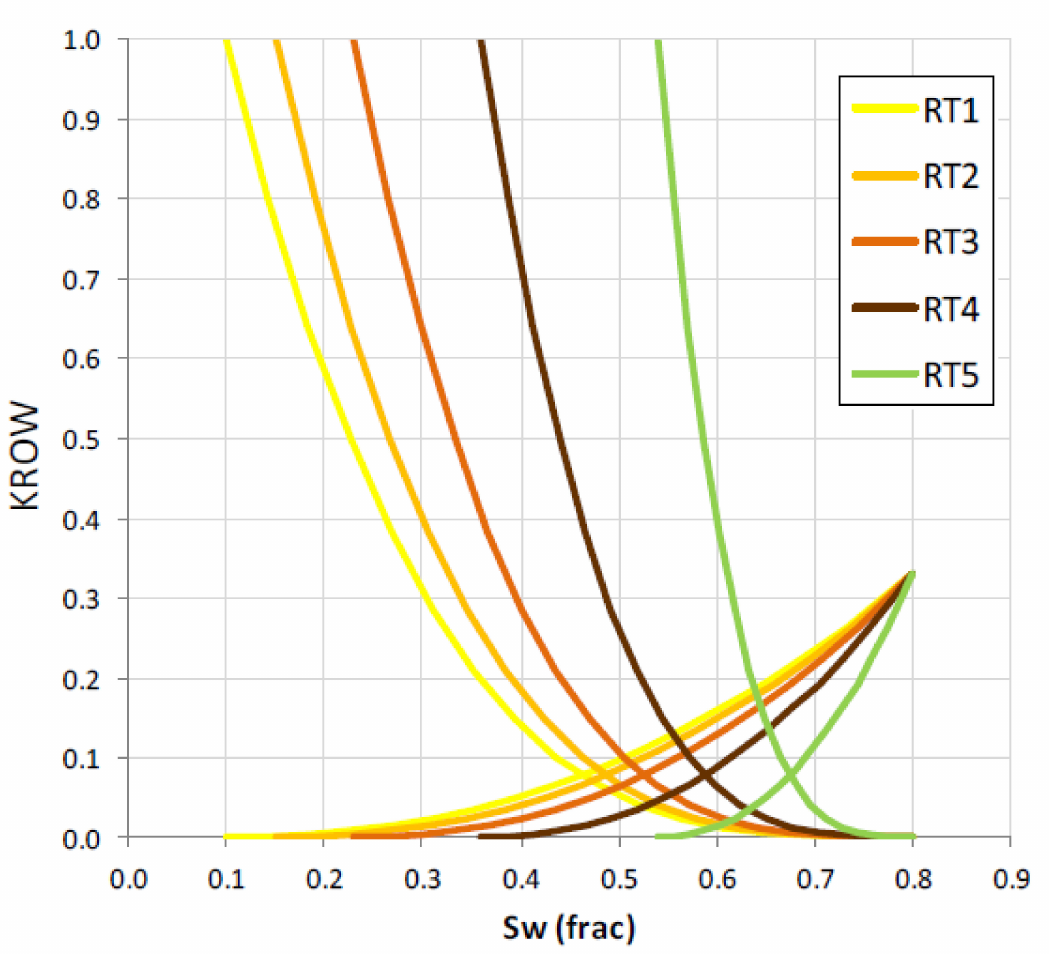
Figure 4. The relative permeability function for each rock